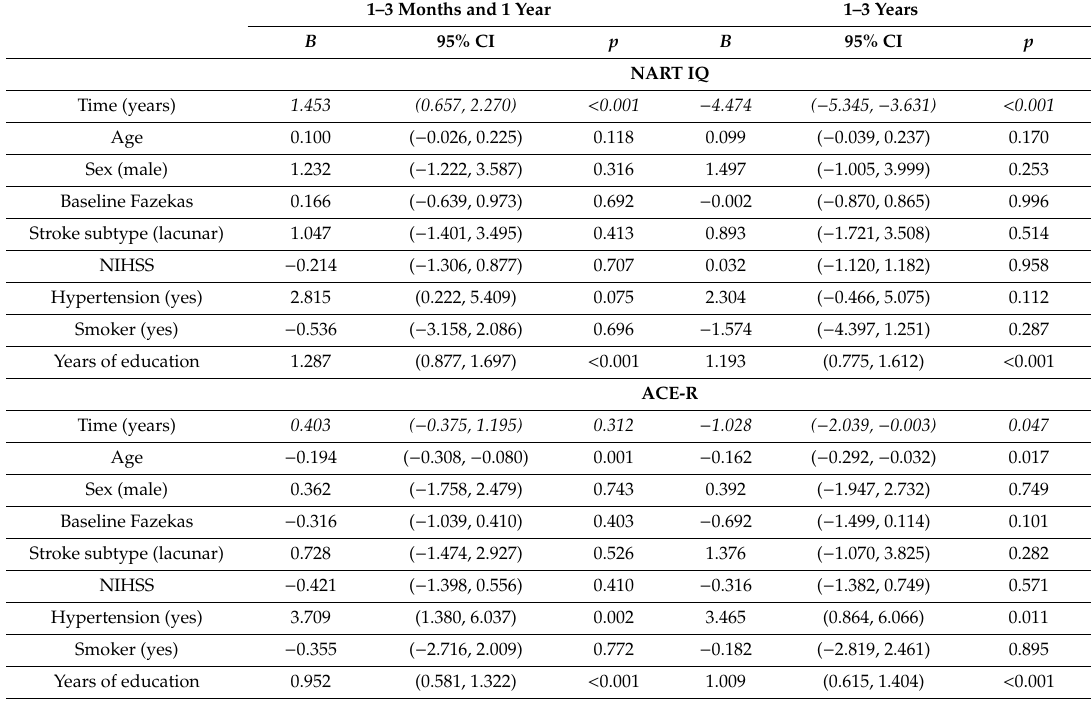
Table 3. Linear mixed e ff ects model showing the associations between time and NART IQ and ACE-R adjusted for baseline